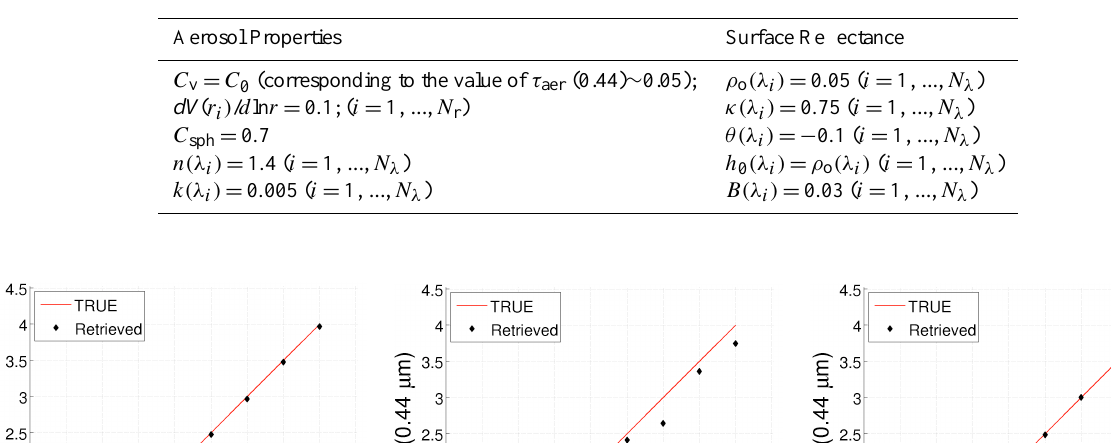
Table 6. Definition of “ the initial guess” for the vector of unknowns.